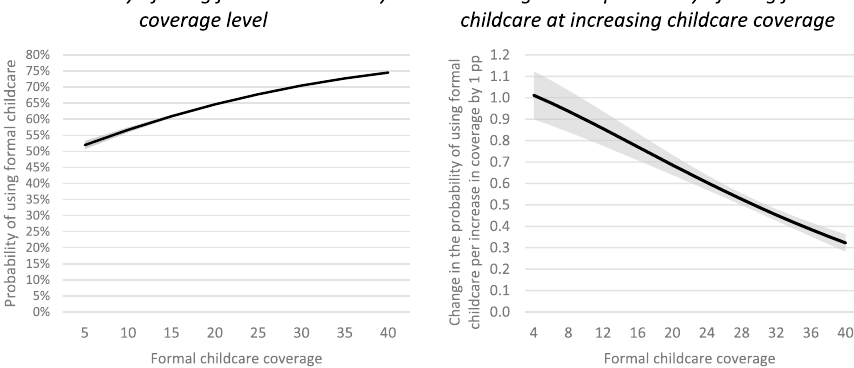
Fig. 4 a Probability of using formal childcare at different levels of childcare coverage and b change in the probability of using formal childcare for a 1 percentage point increase in childcare coverage at different levels of childcare coverage (with 95% conf. interval). a Predicted probabilities and b average marginal effects based on Model 1 including municipality fixed effects and childcare coverage (quadratic specification) (Source: Belgian Census 2011 linked to longitudinal register data, longitudinal tax return data on childcare expenses and municipality-level data on childcare coverage from K&G and ONE. Calculations by authors)